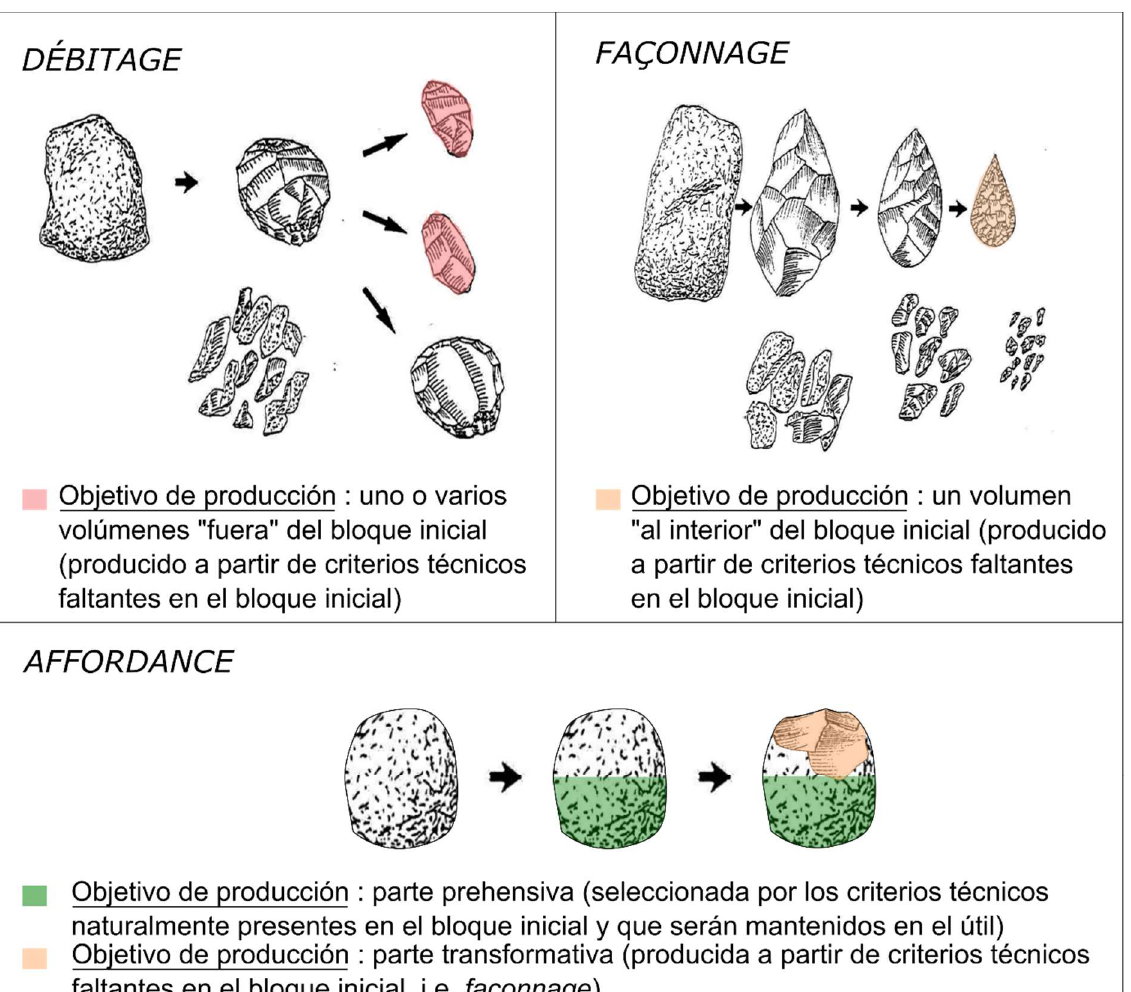
Figura 10. Tres operaciones técnicas implicadas en la producción de útiles líticos (elaborado a partir de Boëda 1997: fig.